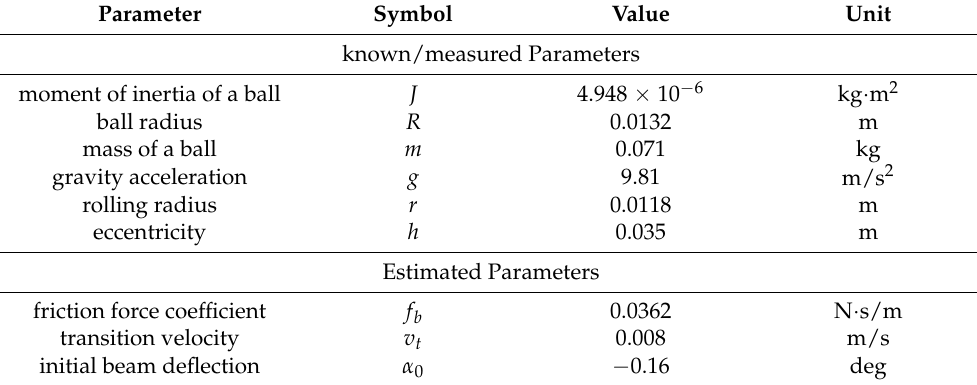
Table 1. List of parameters used in numerical calculations.